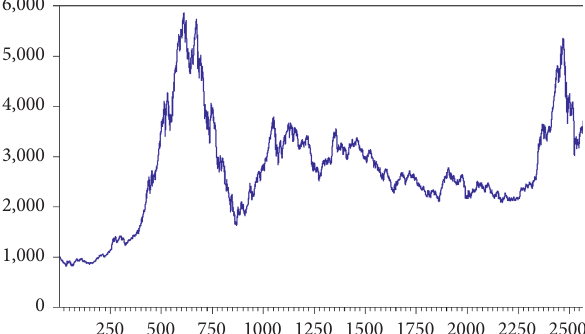
Figure 5: Trend chart of the CSI 300 index.